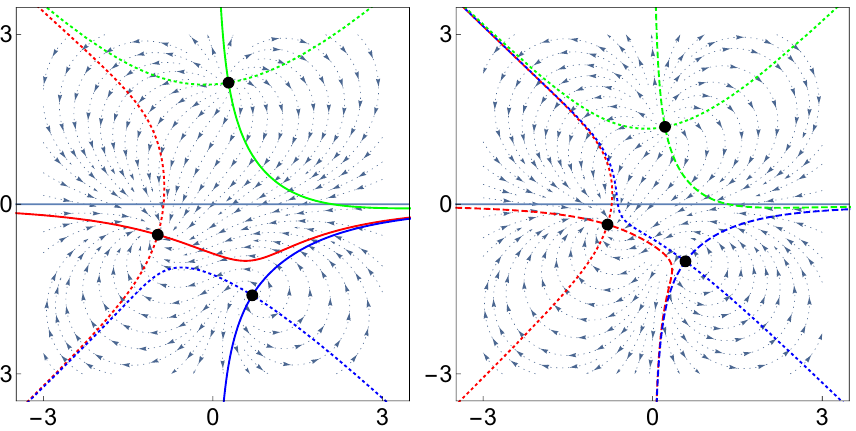
Figure 3: Complex plane with drift and thimble structure of the z 4 one-site model with one (left) and two (right) contributing thimbles. Table 1: Numerical results and exact values of observables with statistical errors. Possible deviations are caused by numerical discretization